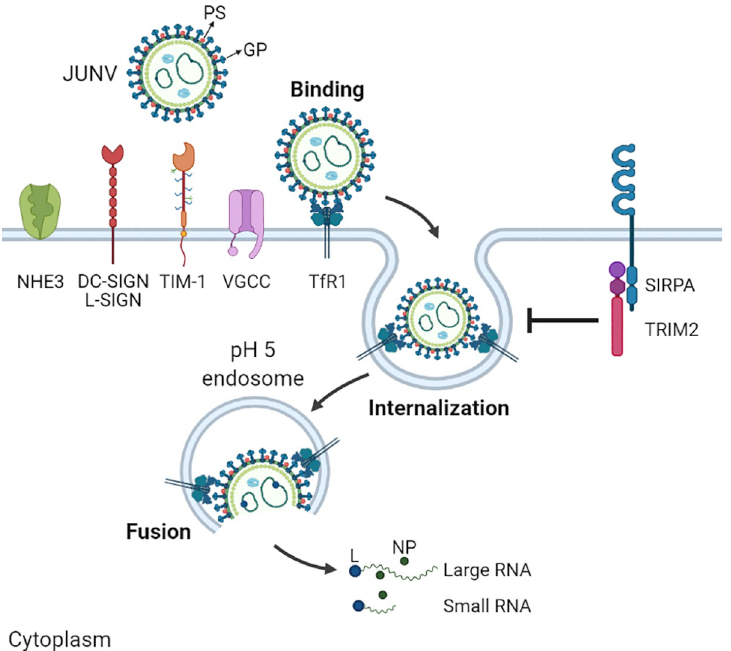
Fig 1. Cellular proteins involved in NWA cellular entry. JUNV uses TfR1 as its main entry receptor on human cells, while it and other NWAs use VGCCs for entry when they cannot use TfR1, such as for infection of mouse cells. NWAs also target additional cell surface attachment factors that enhance binding. NWAs also bind PS receptors, such as TIM-1 due to PS incorporated into viral membranes during budding. Upon binding, virus particles are internalized by endocytosis. The RFs TRIM2 and SIRPA decrease the levels of NWA internalization. Virus-containing endocytic vesicles traffic to acidic endosomes (pH 5) where fusion of the viral and cellular membrane occurs, and the viral genomic RNAs, bound to the L and the NP found in the nucleocapsid, are released into the cytoplasm. Figure created with BioRender (https://app.biorender.com). DC-SIGN, dendritic cell–specific intercellular adhesion molecule- 3-grabbing non-integrin; GP, glycoprotein; JUNV, Junı´n virus; L, polymerase; L-SIGN, liver/lymph node-specific ICAM-3-grabbing non-integrin; NHE3, sodium hydrogen exchanger 3; NP, nucleoprotein; NWA, New